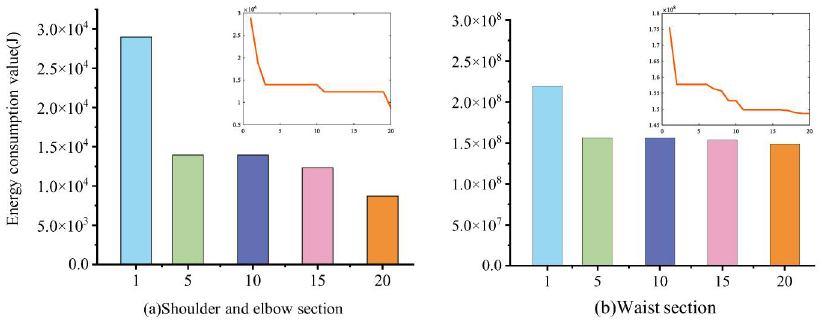
Figure 10. Energy consumption trends for different